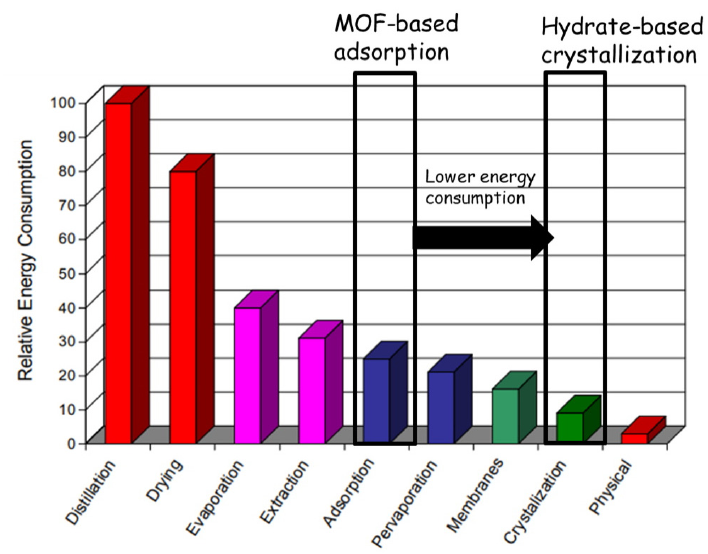
Figure 5. Relative energy use by various separation technologies [48] (Figure used here is from the open access report available at the following link: https://www1.eere.energy.gov/manufacturing/in ‐ dustries_technologies/imf/pdfs/separationsreport.pdf).(Accessed date is 21 December 2022)